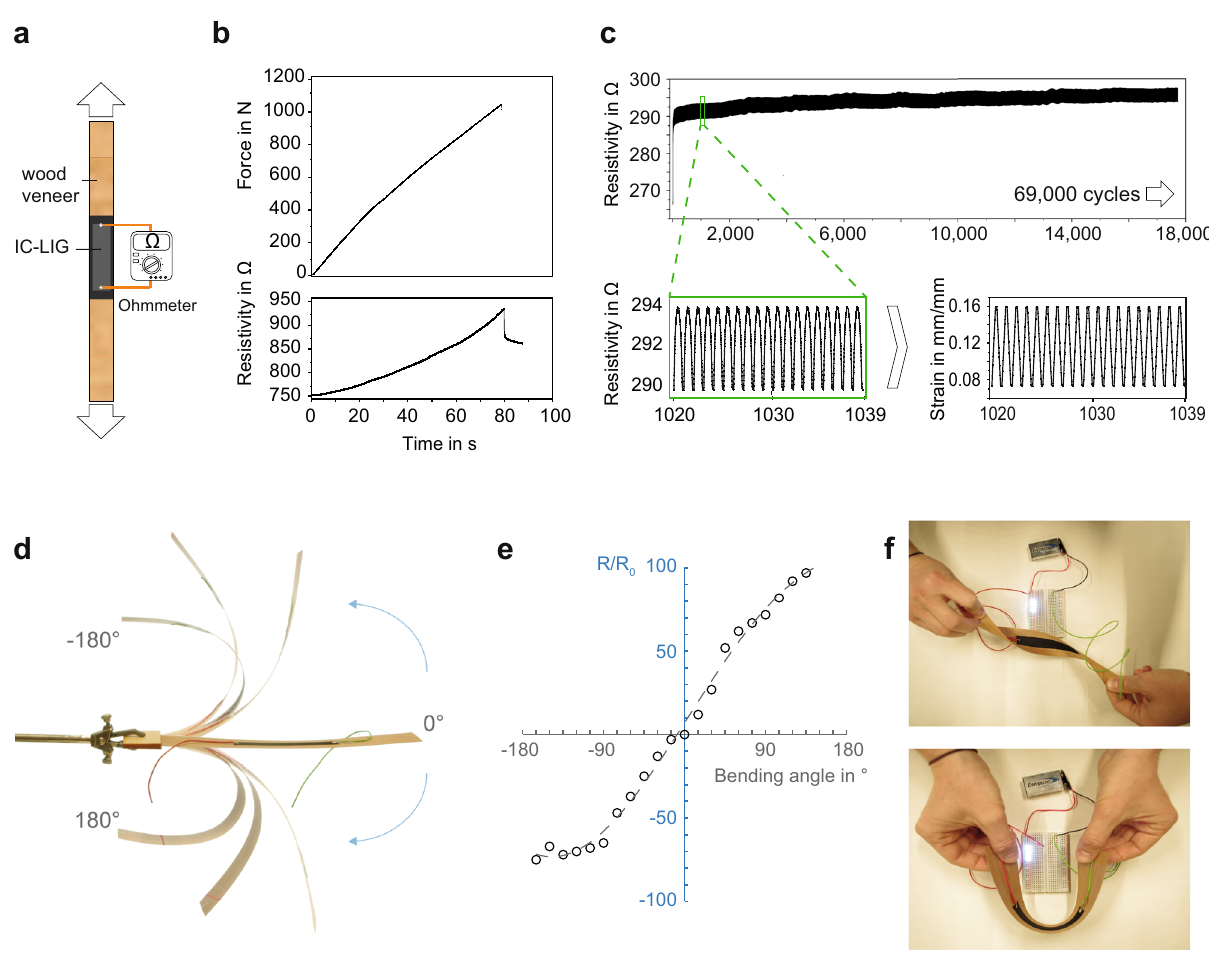
Fig. 4 IC-LIG-Wood for strain sensors and fl exible electrodes. a Schematic representation of a proof-of-concept IC-LIG-wood strain sensor (the arrows indicate the direction of tensile stress application) for measuring the change of resistivity as a function of applied force. b Force-time plot with the corresponding resistivity-time plot for a representative IC-LIG-spruce veneer. c Resistivity values measured under tensile load cycles with a representative IC-LIG-beech veneer. The measurements were performed for more than 69,000 cycles. The slight increase in resistivity over time is most probably due to the creep of wood veneer during the cycling test. The inset highlights the periodic resistivity change, and the direct correlation between the measured resistivity data from source measure unit with the measured strain values from clip-on extensometer. d Picture overlay showing an IC-LIG fl exible electrode obtained on a thin cheery wood veneer, which allows for extensive bending angles. e Relationship between the bending angle and the associated resistivity change R/R 0 . f Pictures showing the stability of electrical connection even under twisting and bending. Here the fl exible IC-LIG-wood electrode is used to connect a battery with a LED